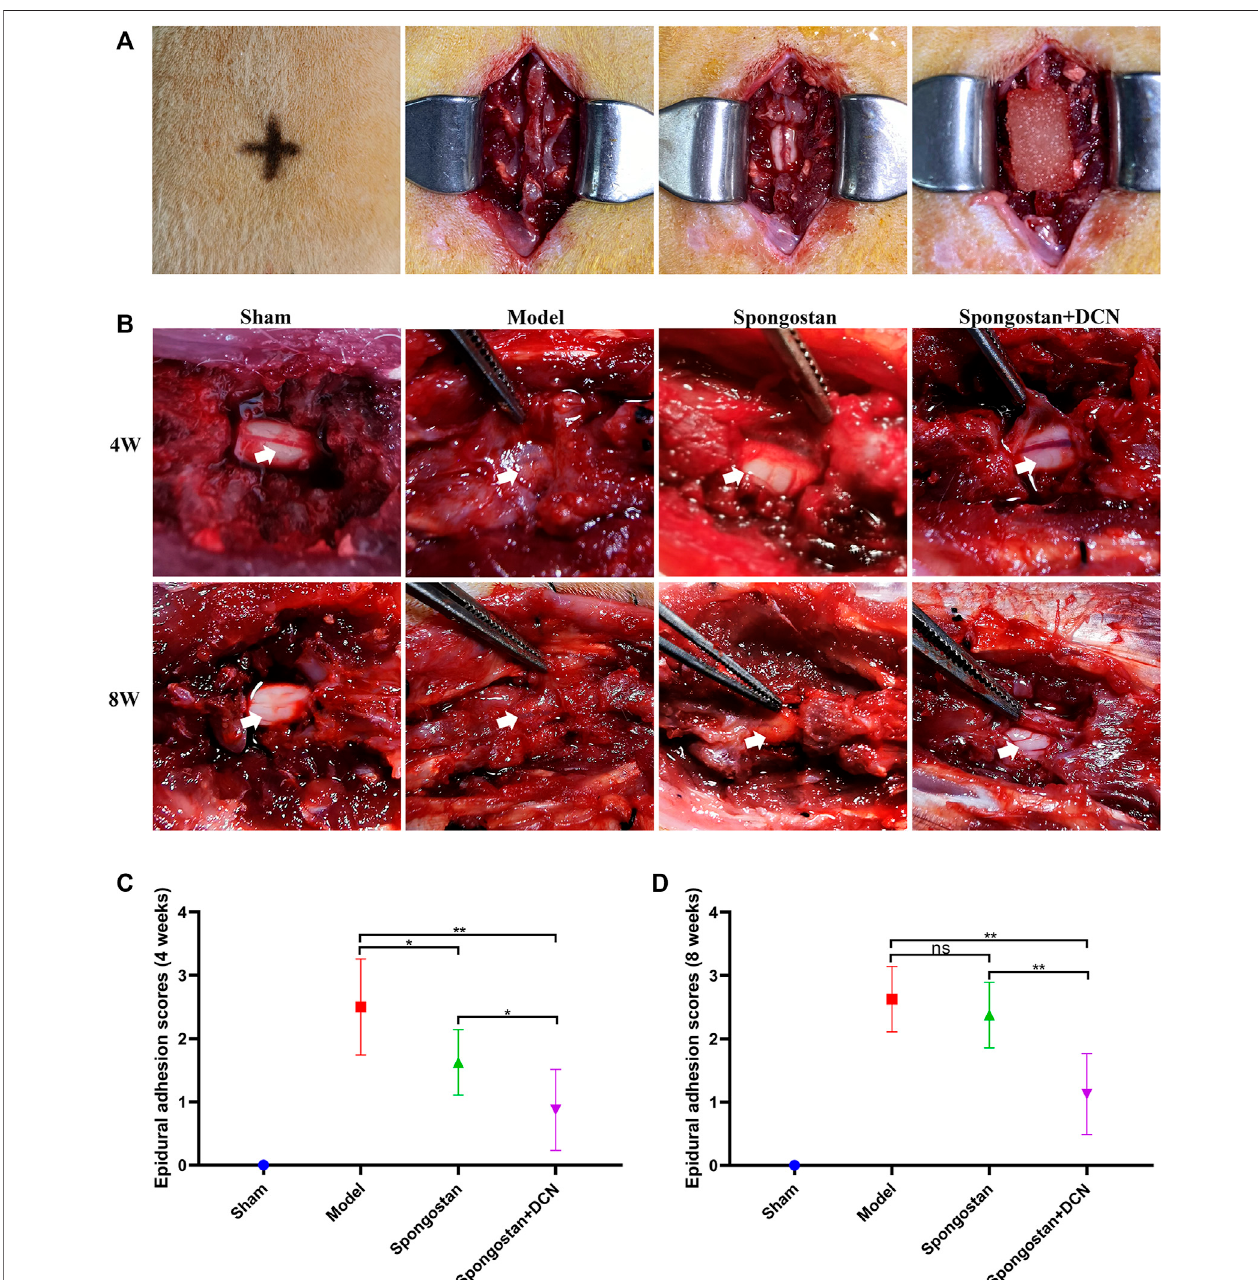
FIGURE 6 | Establishment of a rat laminectomy model and gross observation of the epidural adhesions. (A) The process of building the model: surface location of L1, exposing the lamina, excision of lamina, and aspongostanimpregnated withsaline or decorin (DCN) solutionwas retained on the dura mater. (B) Gross observation of laminectomy sites after 4 and 8 weeks of treatment. White arrows indicate the dura mater. (C) Four weeks and (D) 8 weeks of epidural adhesion score results based on Rydell standard. ns indicates no signi fi cance. * p < 0.05; ** p < 0.01.